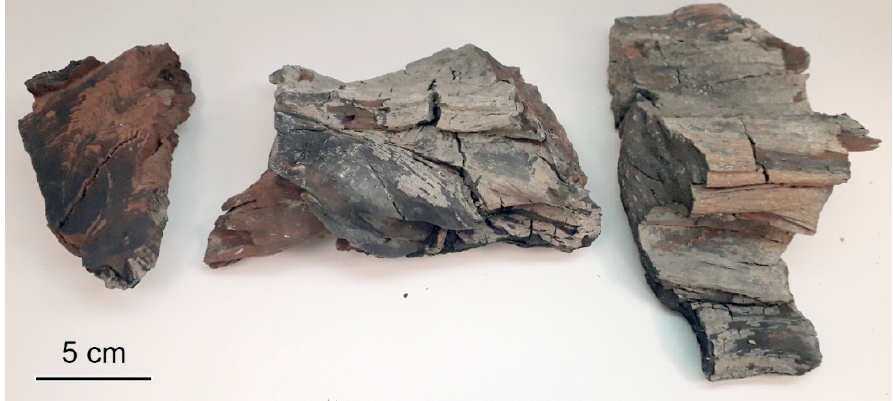
Figure 1. Fragments of fossil woody stem examined in the present study.